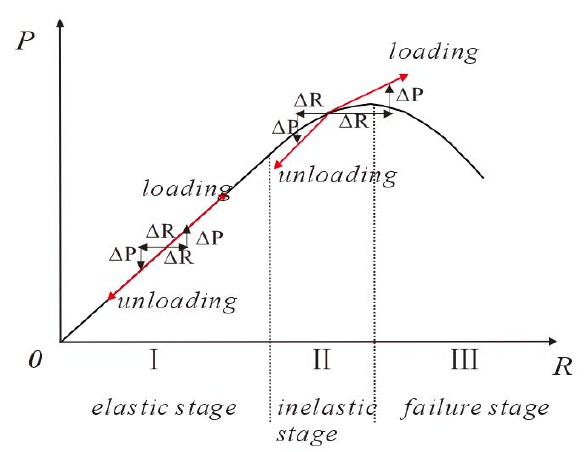
Figure 6. Schematic diagram of the constitutive relation of rock. P and R represent, respectively, the load and response. At stage I, the responses ( ∆R ) to the small changes of ∆P in the loading and unloading are almost the same, while at the stage II, the response to the loading is significantly greater than the unloading, and the stage Ⅲ is characterized with macroscopic damage..